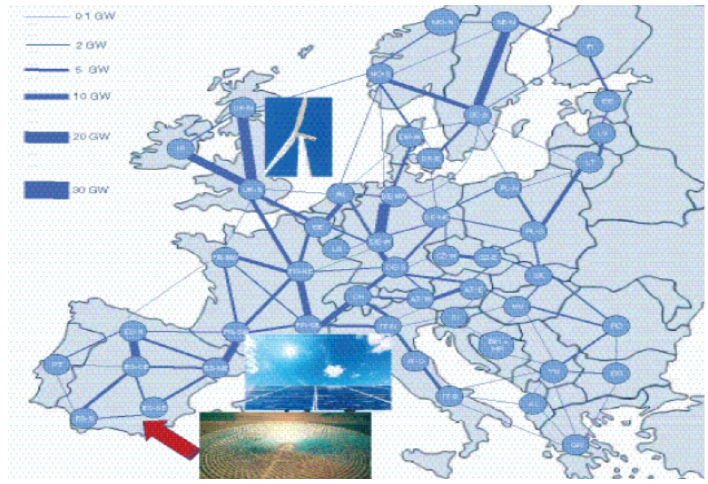
Figure 2. Mega-project of West European Electric Power Interconnection [16].